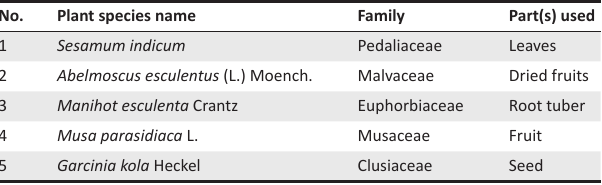
Herbal recipes for two powdered drugs: CONVU-B (1 + table salt) and CONVU-C (2, 3, 4 + table salt); suffix alphabets indicate the manufacturers’ anonymity codes. CONVU, convulsion. TABLE 8: Names of plants and their parts used for the formulation of traditional oral powdered herbal formulations for the treatment of male erectile dysfunction in Ogbomoso, Nigeria.